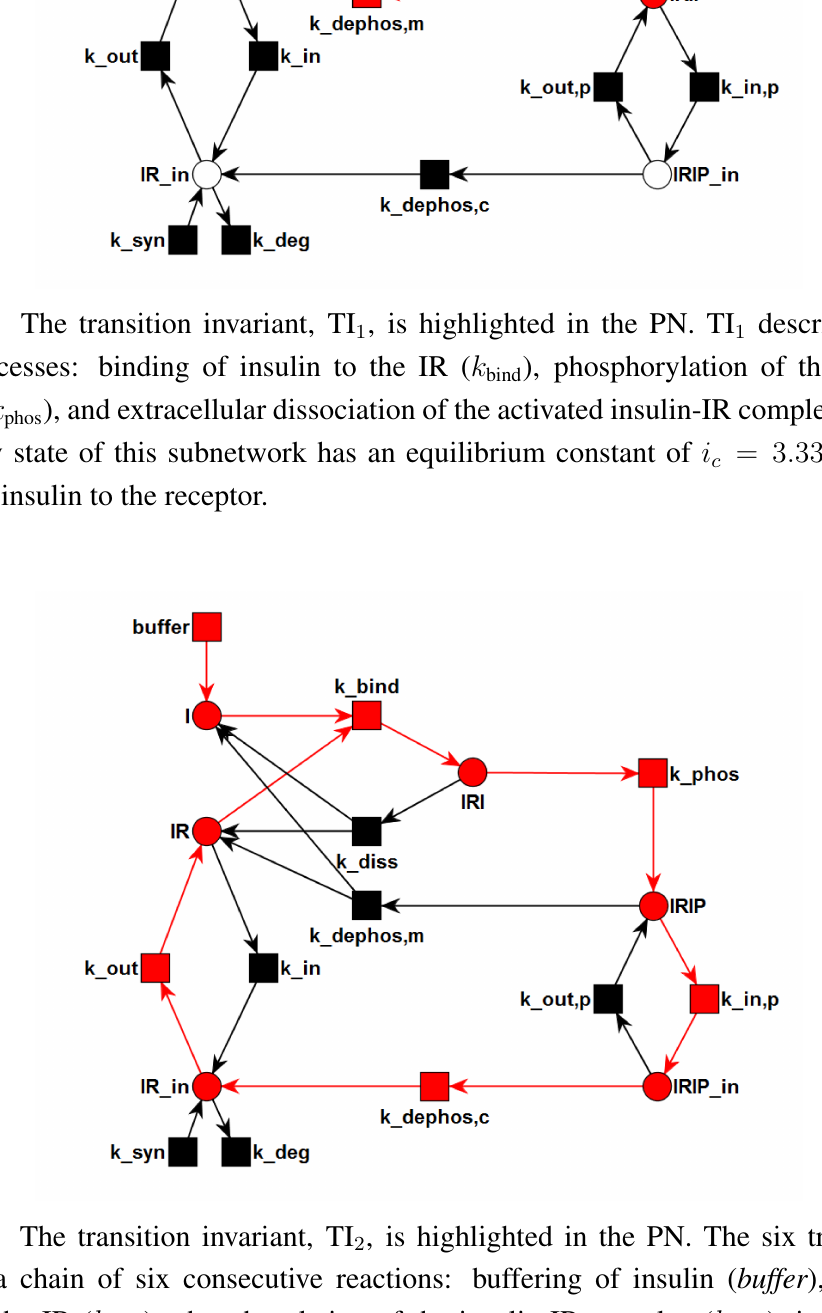
), internalization phos out